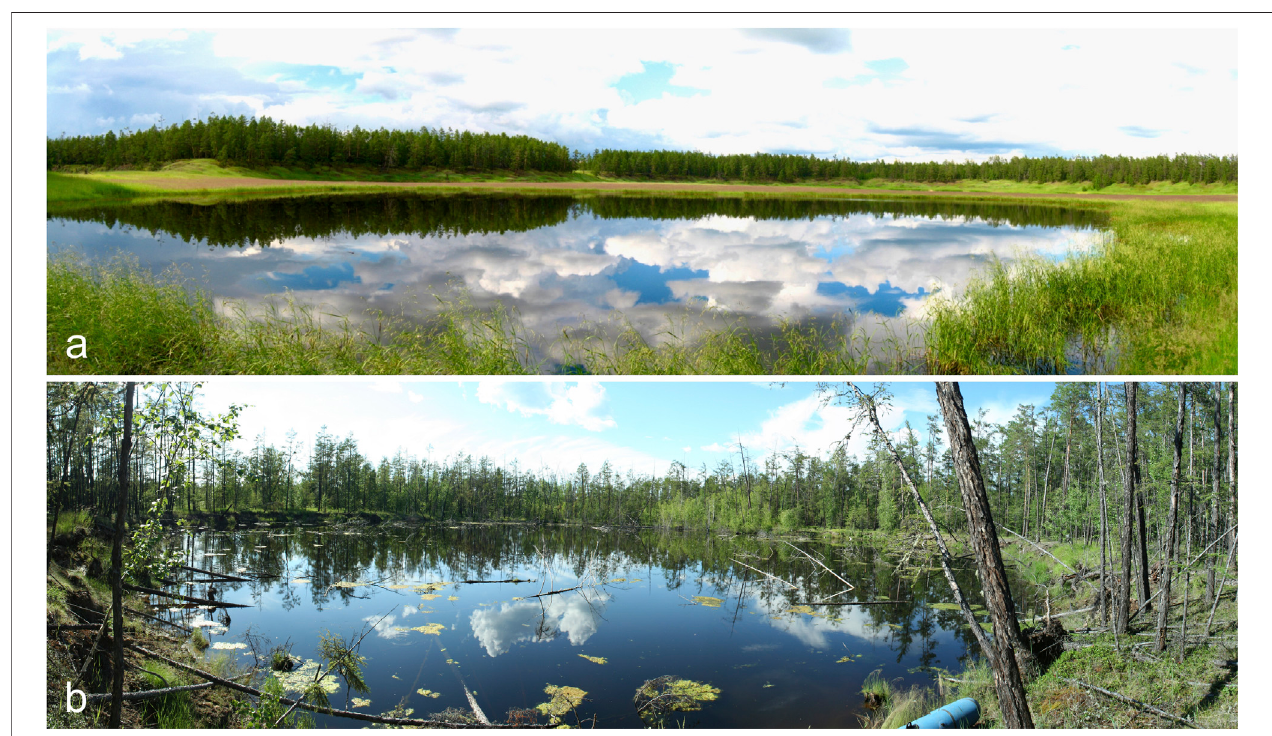
FIGURE 2 | Photographs of the drilled lakes at the Yukechi study site during summer with views to Northwest: (A) YU-L7, (B) YU-L15.